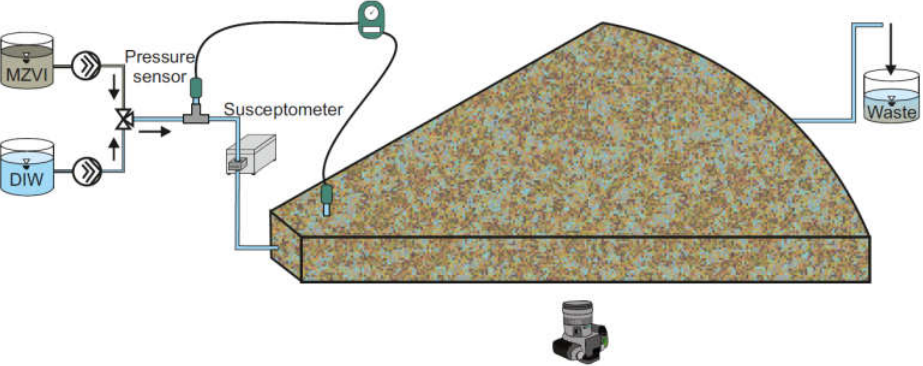
Figure 1. Experimental radial setup for iron transport tests.